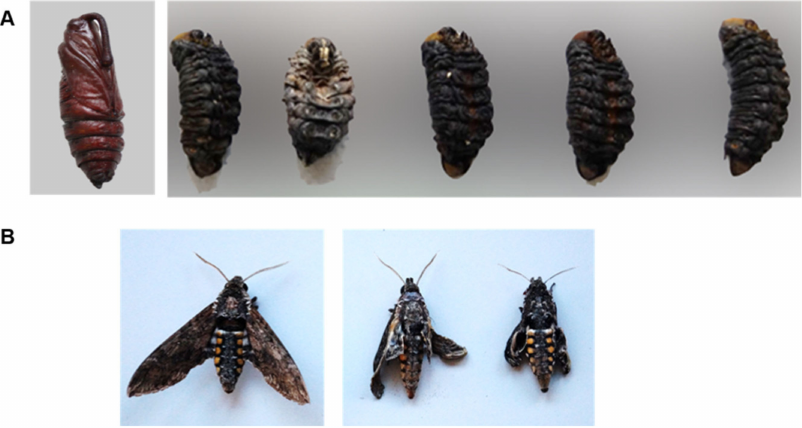
Figure 1. The impact of root colonization by Rhizophagus irregularis or Trichoderma harzianum on the morphology of the pupae and moths developed by Manduca sexta larvae that had fed from root-inoculated tomato plants. ( A ) Representative pupae with anomalous morphology developed by larvae that had fed from T. harzianum -inoculated plants (right panel), and a representative pupa presenting normal morphology developed by larvae that had fed form non-inoculated plants (left panel). ( B ) Representative Manduca sexta moths showing anomalous morphology (underdeveloped wings) formed by larvae that had fed from R. irregularis -inoculated plants (right panel) and a representative moth presenting normal morphology developed by larvae that had fed form non- inoculated plants (left